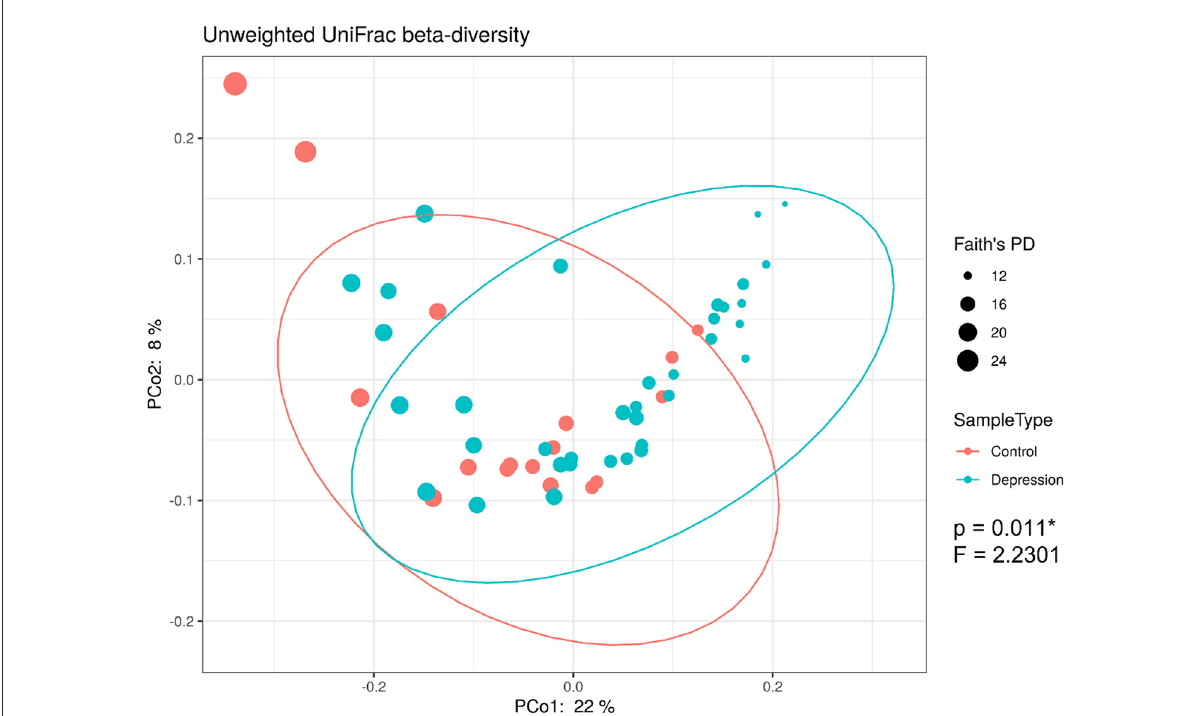
FIGURE3 16S rRNA gene data revealed significant beta-diversity between the gut microbiota from late-life depression (LLD) patients and healthy controls. Principal coordinate analysis (PCoA) on the unweighted UniFrac distance matrix from the rarefied data was used to evaluate the presence of clusters or groupings based upon operational taxonomic unit (OTU)-level microbial